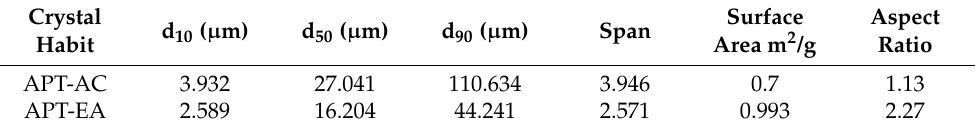
Table 2. Particle size distribution.